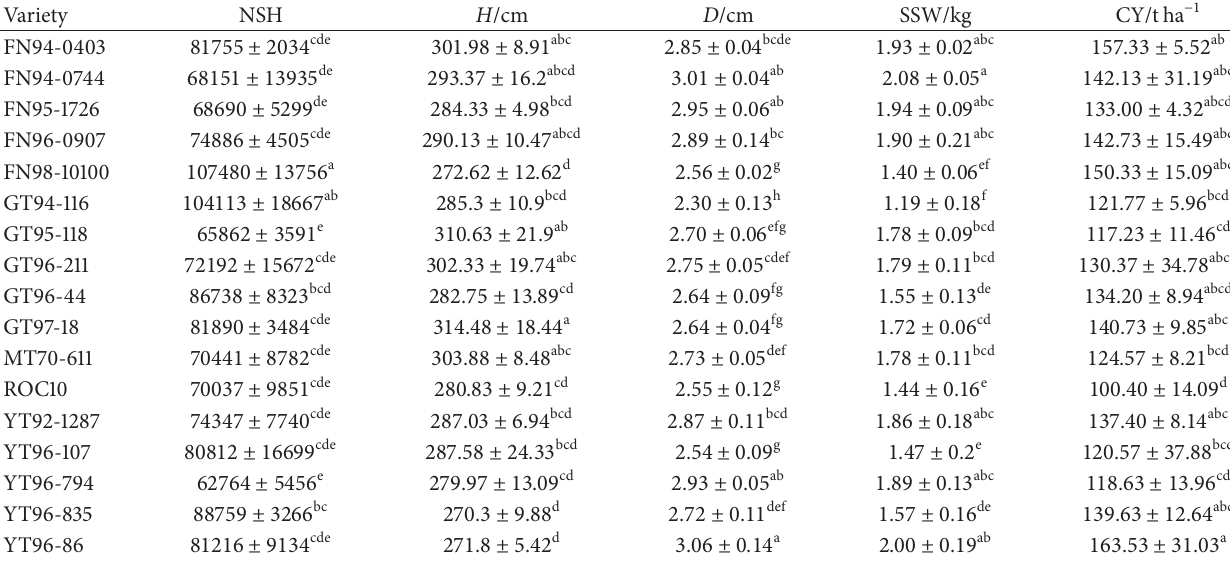
Table 1: Cane yield traits of 17 sugarcane